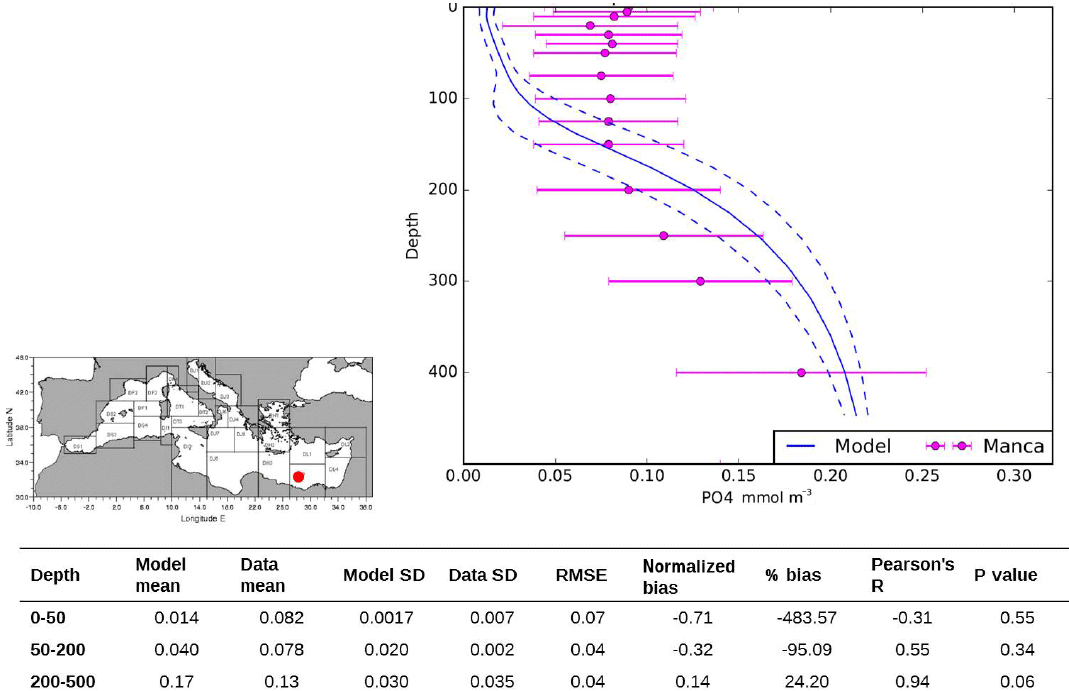
Figure A2. Annually averaged PO 4 vertical profile in the south Levantine sub-basin (see map and Manca et al., 2004) and statistical indicators over different depths. Model values are shown with the blue line (2005 average, Ntot simulation from Richon et al., 2017) and measured values from Manca et al. (2004) are in pink. Horizontal bars and dashed lines indicate the spatial SD of observations and model results